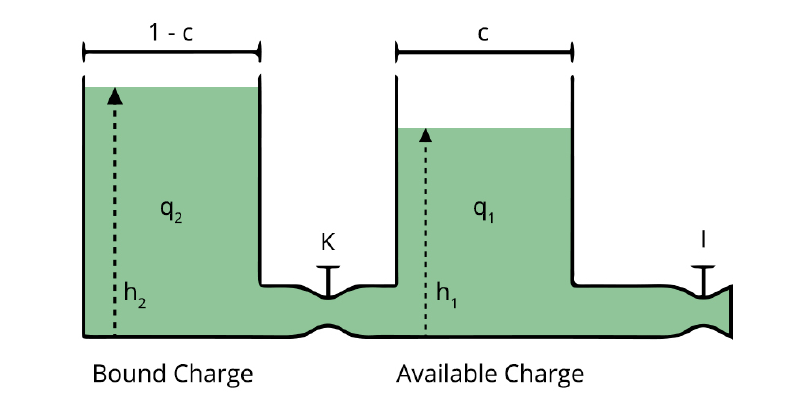
Figure 1. KiBaM battery model [67]. Reprinted from [67] with permission (License 4844200377381) from